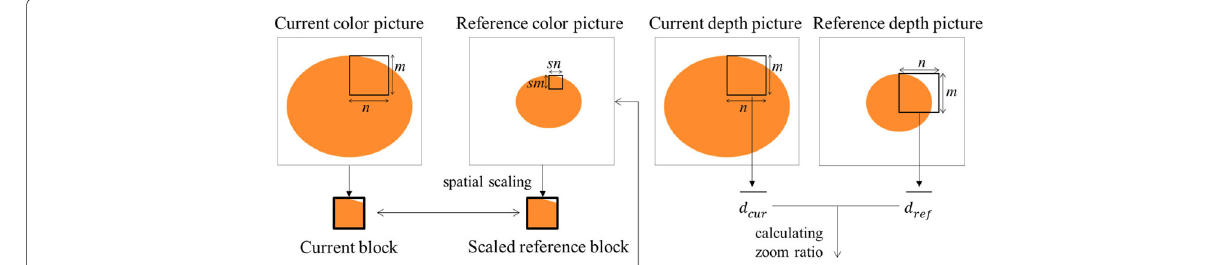
Fig. 4 Processes of proposed method for color video